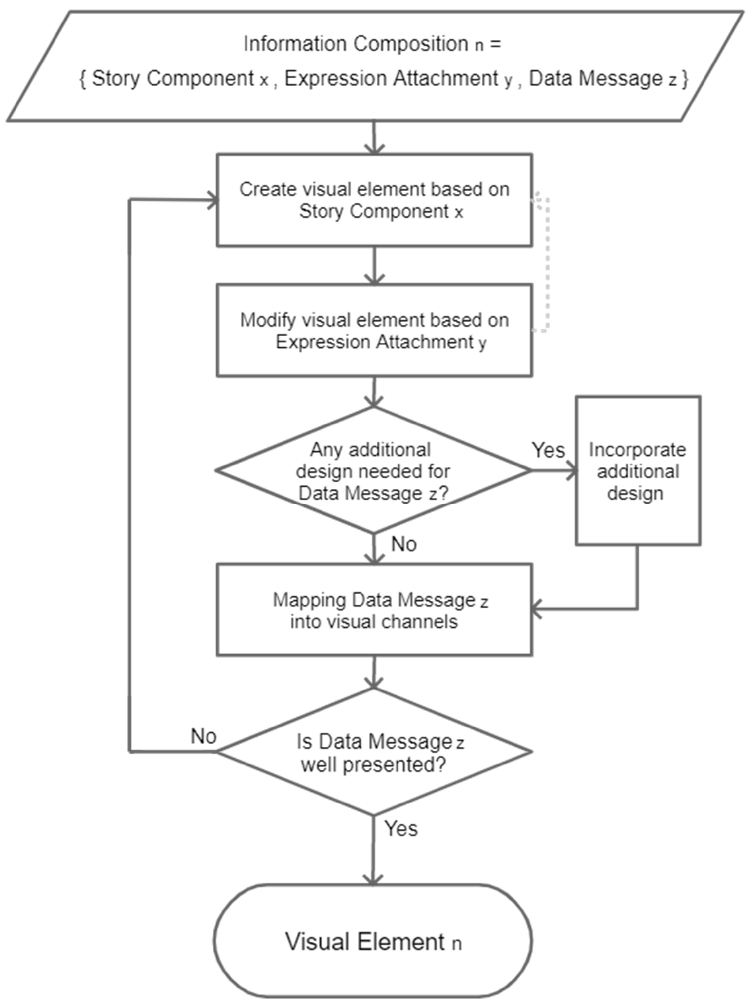
Figure 11. Logic flowchart of the translating process from an information composition to a visual visual element.